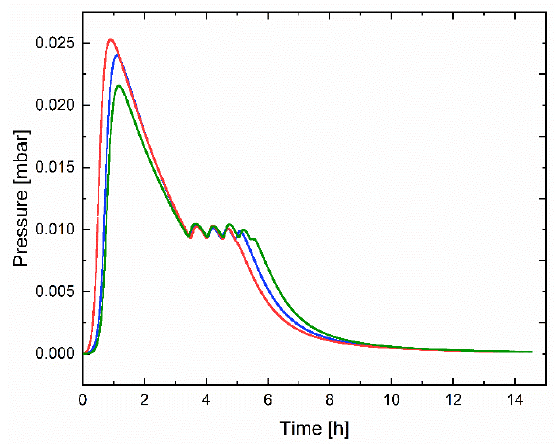
Figure 19. Comparison of three H 2 regenerations performed with the same nominal temperature of 550 °C and the feedback control of the heating to demonstrate repeatability.